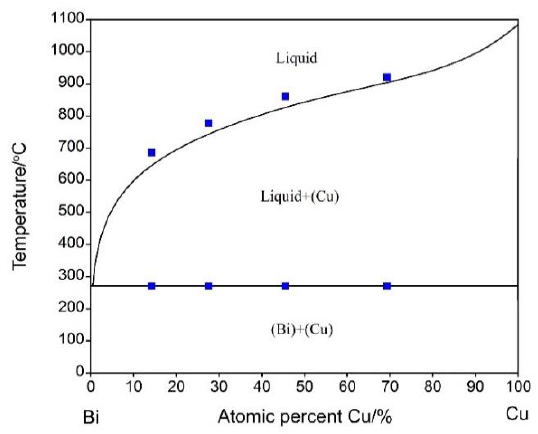
Fig. 7. The optimized phase diagram of the Bi-Cu system [9,19] with the DSC results from the present